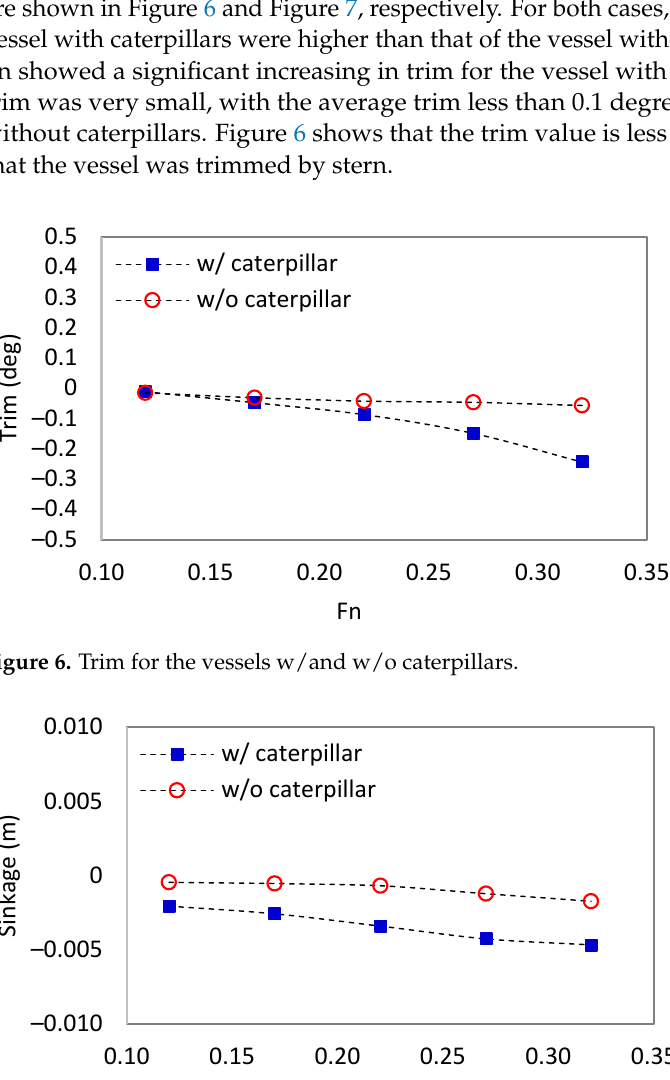
Figure 5. Components of resistance coefficient (Ct, Cf, and Cp): ( a ) w/ caterpillars, ( b ) w/o caterpillars.